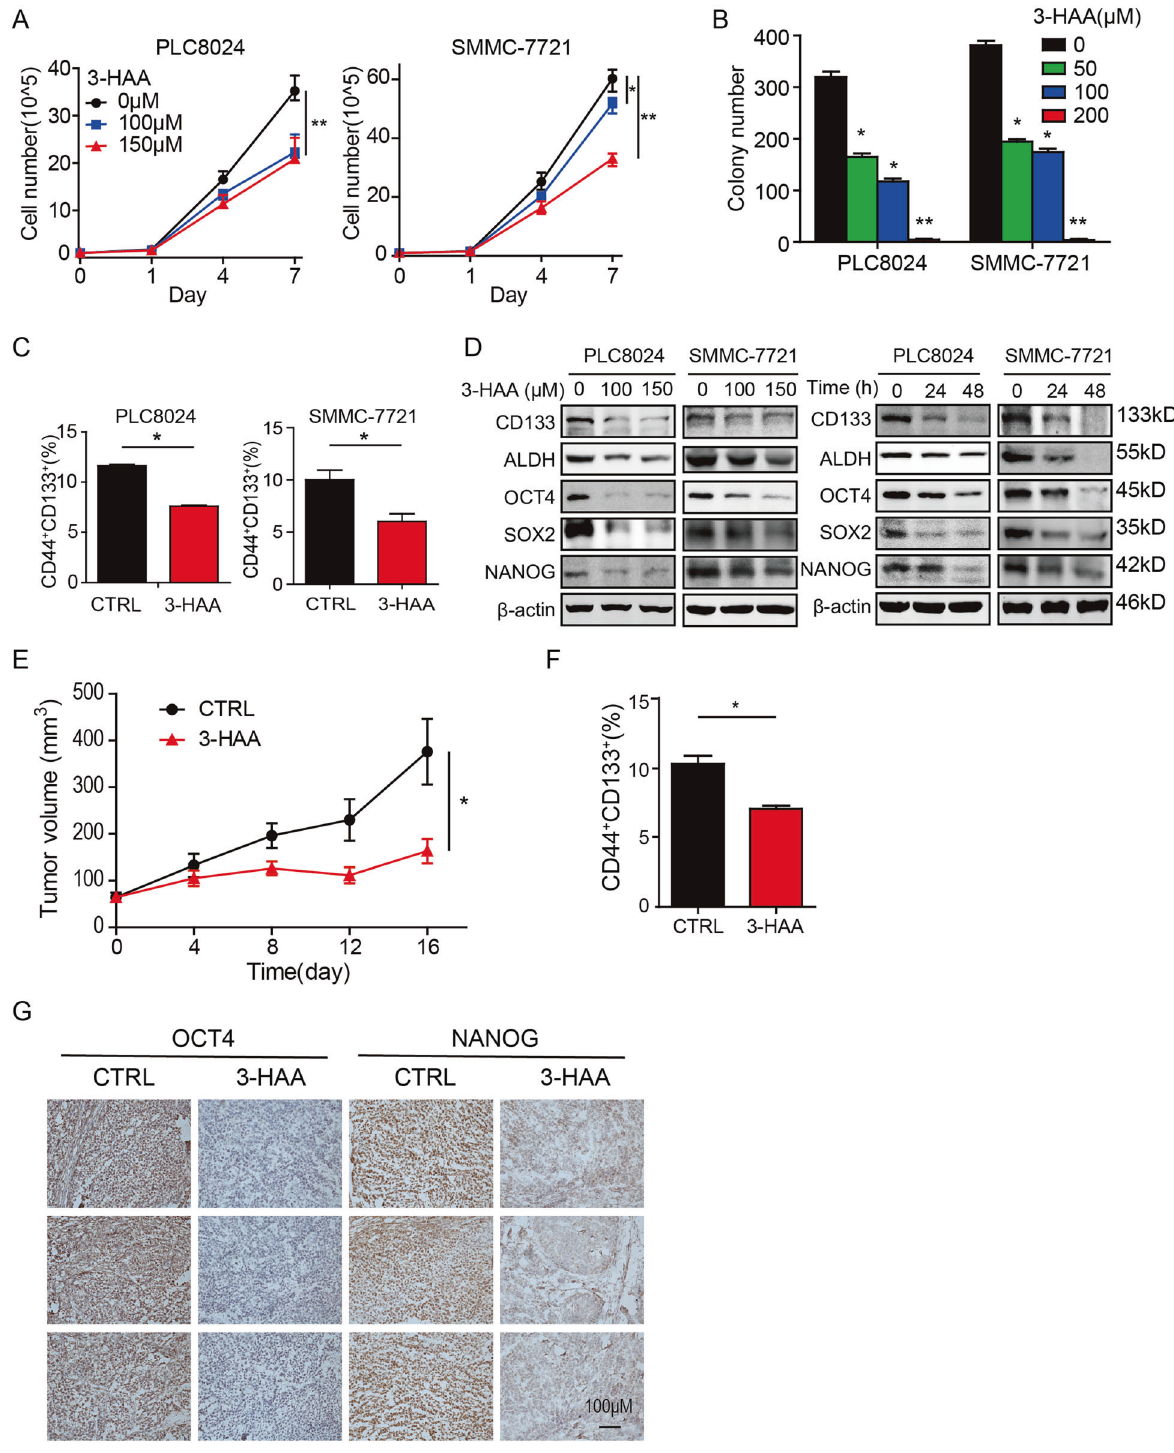
Fig. 3 3-hydroxyanthranic acid inhibits tumor stemness of sorafenib-resistant HCC cells. A 3-HAA inhibited cell growth of sorafenib- resistant HCC cells. Cell numbers of HCC cells were counted by cytometry. Data were presented as mean ± SD ( n = 3). * P < 0.05, ** P < 0.01. B 3-HAA reduced colony formation in sorafenib-resistant SMMC-7721 and PLC8024 cells. Cells were treated with 3-HAA at the indicated dose. * P < 0.05, ** P < 0.01. C The ratio of CD44 + CD133 + subpopulation was decreased in 3-HAA-treated SMMC-7721 and PLC8024 cells. Cells were treated with 3-HAA at the dose of 100 μ M for 48 h. * P < 0.05. D 3-HAA inhibited the expression of stem cell markers in HCC cells. The treating time was 48 h for the dose – response experiment and the dose of 3-HAA was 100 μ M for the time-course analysis. E 3-HAA suppressed tumor growth of SMMC-7721 xenografts. The 3-HAA was administrated 100 mg/kg day by intraperitoneal injection for 16 days, fi ve mice were recruited in the control and 3-HAA-treated group. The tumor volumes were presented as mean ± SD. * P < 0.05. F 3-HAA decreased the proportion of CD44 + CD133 + subpopulation in SMMC-7721 xenografts. Tumor cells were analyzed by fl ow cytometry using anti-CD133-PE and anti-CD44-APC. * P < 0.05. G 3-HAA inhibited the expression of stem cell markers in SMMC-7721 xenografts. Bar = 100 μ m. Cell Death Discovery (2021)